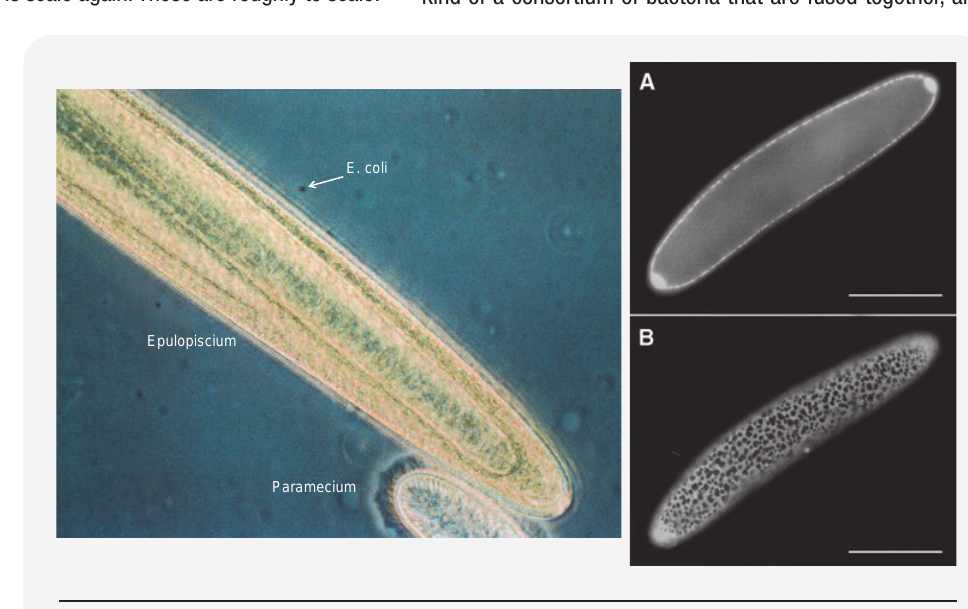
Figure 9. An example of a giant bacterium, Epulopiscium, with extreme polyploidy (shown with DAPI staining, right panel). Epulopiscium can have as many as 200,000 copies of the complete genome, positioned right next to the bioenergetic plasma membrane, as predicted. Extreme polyploidy has a huge energetic cost. Courtesy of E.